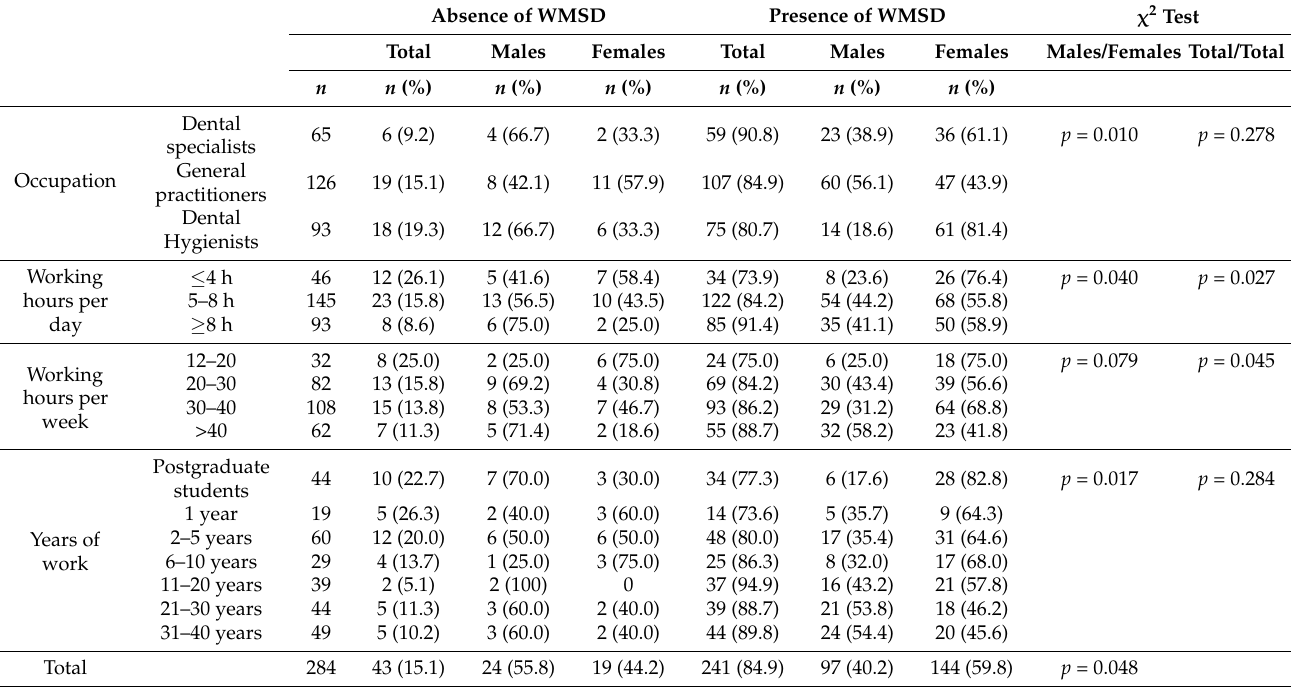
Table 3. WMSD in relation to occupation, working hours per day, working hour per week and years of work (statistical significance for p < 0.05). The increase of working hour/day and working hour per week was significantly associated to a higher occurrence of WMSD ( p <